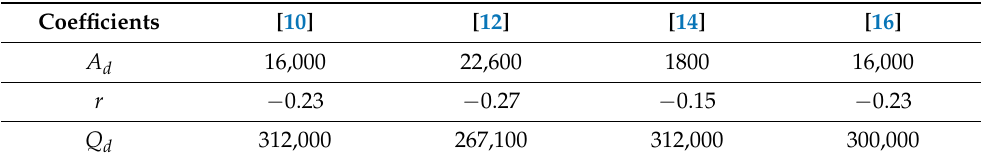
Table 2. Parameters used in the grain size equation for dynamic recrystallization of carbon– manganese steel.